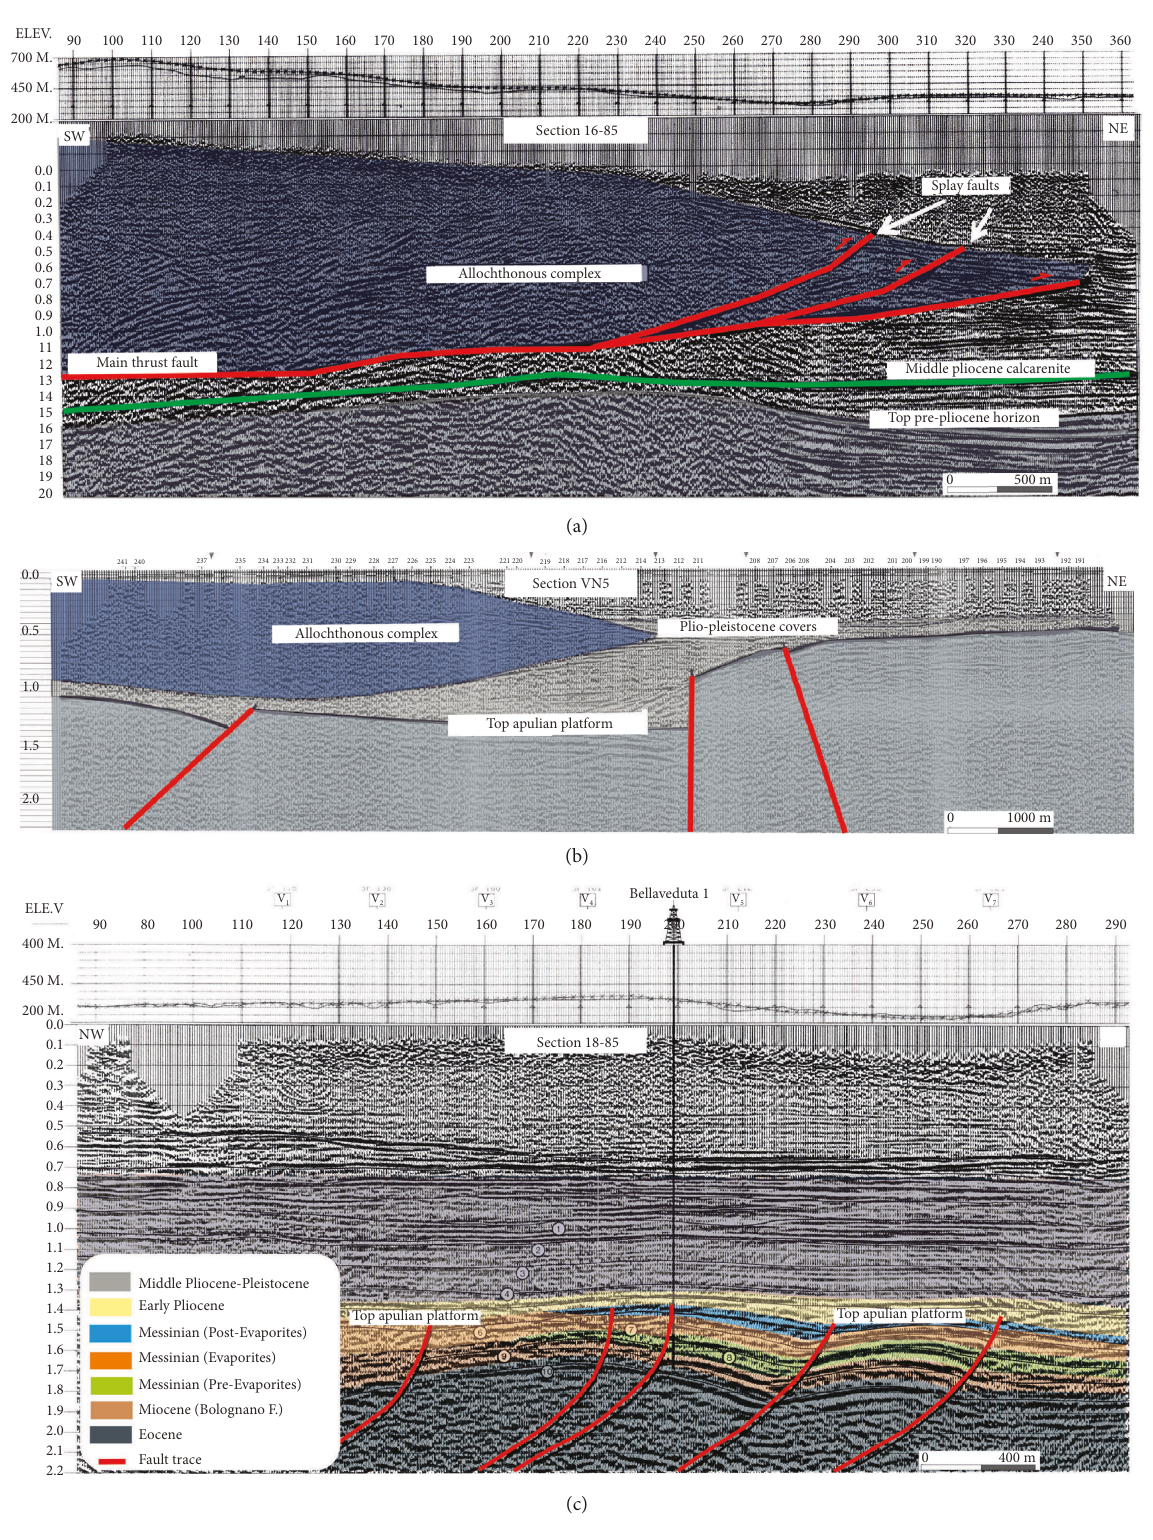
Figure 2: (a) Interpreted NE-SW-oriented seismic re fl ection pro fi les 16-85 in which the main decollement and the splay thrust faults displacing the Pleistocene sedimentary succession are highlighted; (b) interpreted NE-SW-oriented seismic re fl ection pro fi les VN5 across the south-eastern sector of the study area, showing the allochthonous complex overlying the Plio-Pleistocene covers and NW-SE-directed faults displacing the Apulian Platform; (c) interpreted NW-SE-oriented seismic 18-85 across the north-western sector of the study area, showing the listric geometry of the N-S-directed fault zone that displaces gently folded Eocene-Miocene succession. See Figure 1 for